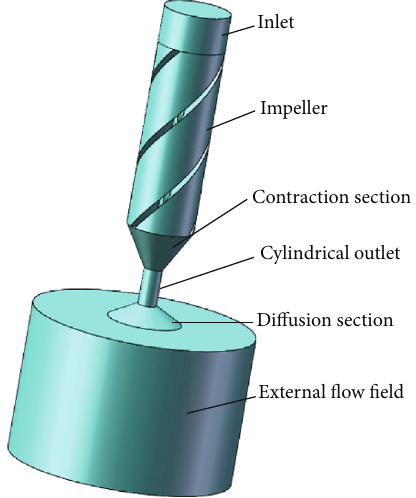
Figure 2: Physical model of swirling abrasive jet